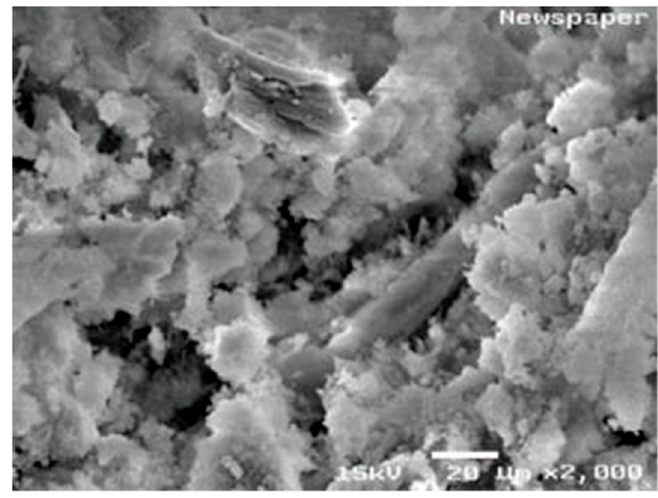
Figure 7. SEM image of cement composite prepared with waste cellulose paper fibre [33] .